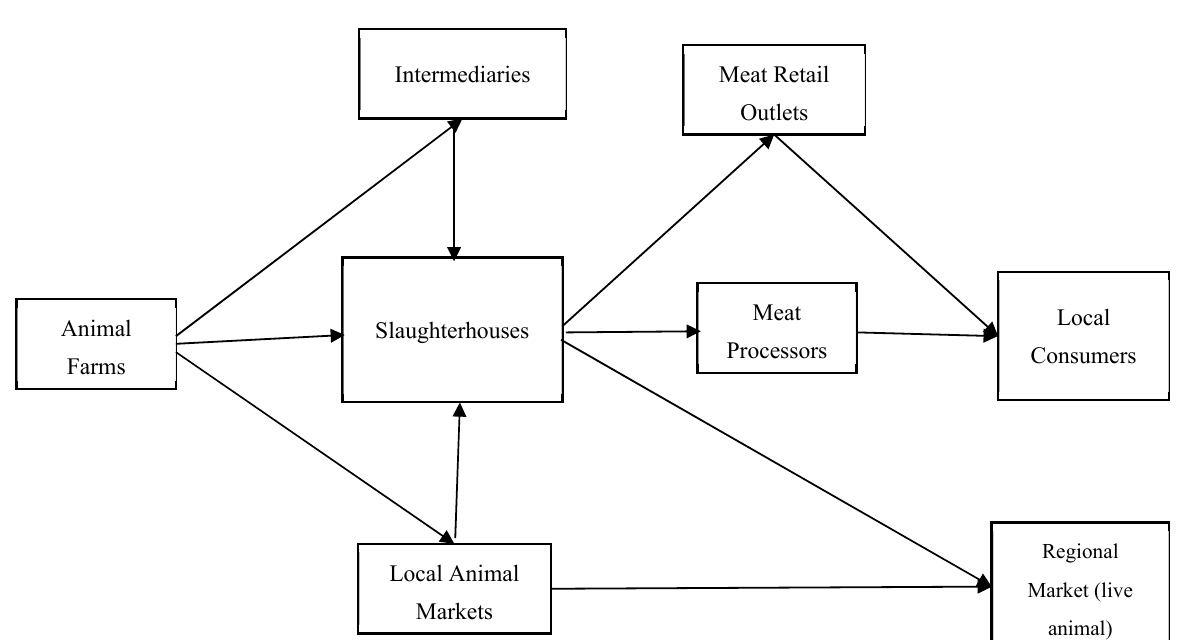
Figure 1. Overview of the Ugandan beef supply chain (source: own description).